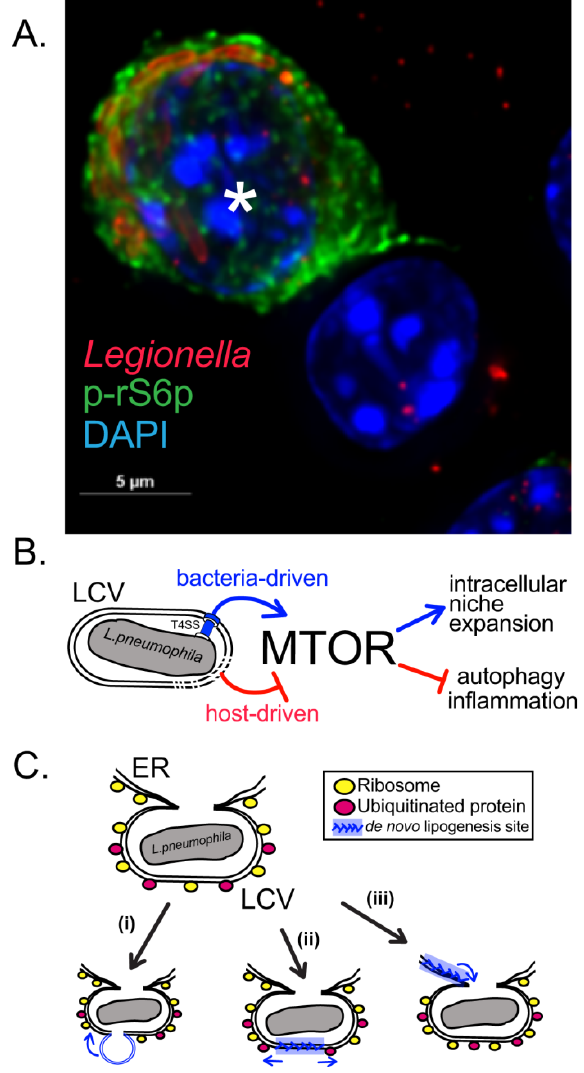
FIGURE 1: MTOR role in Legionella macrophage infections. (A) A representative micrograph depicting robust MTOR signaling in an infected Myd88 -/- BMM (*) but not in an adjacent bystander cell. (B) The balance between multiple regulatory mechanisms dic- tates MTOR signaling in the Legionella infected macrophages. (C) Putative LCV expansion mechanisms through (i) fusion with membrane-bound organelles, (ii) de novo lipogenesis at the LCV or (iii) through ER-derived membrane